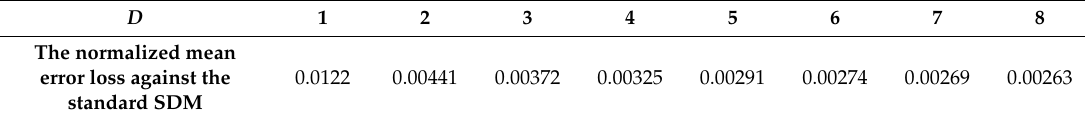
Table 4. The normalized mean error loss against the standard SDM for different choices of D .